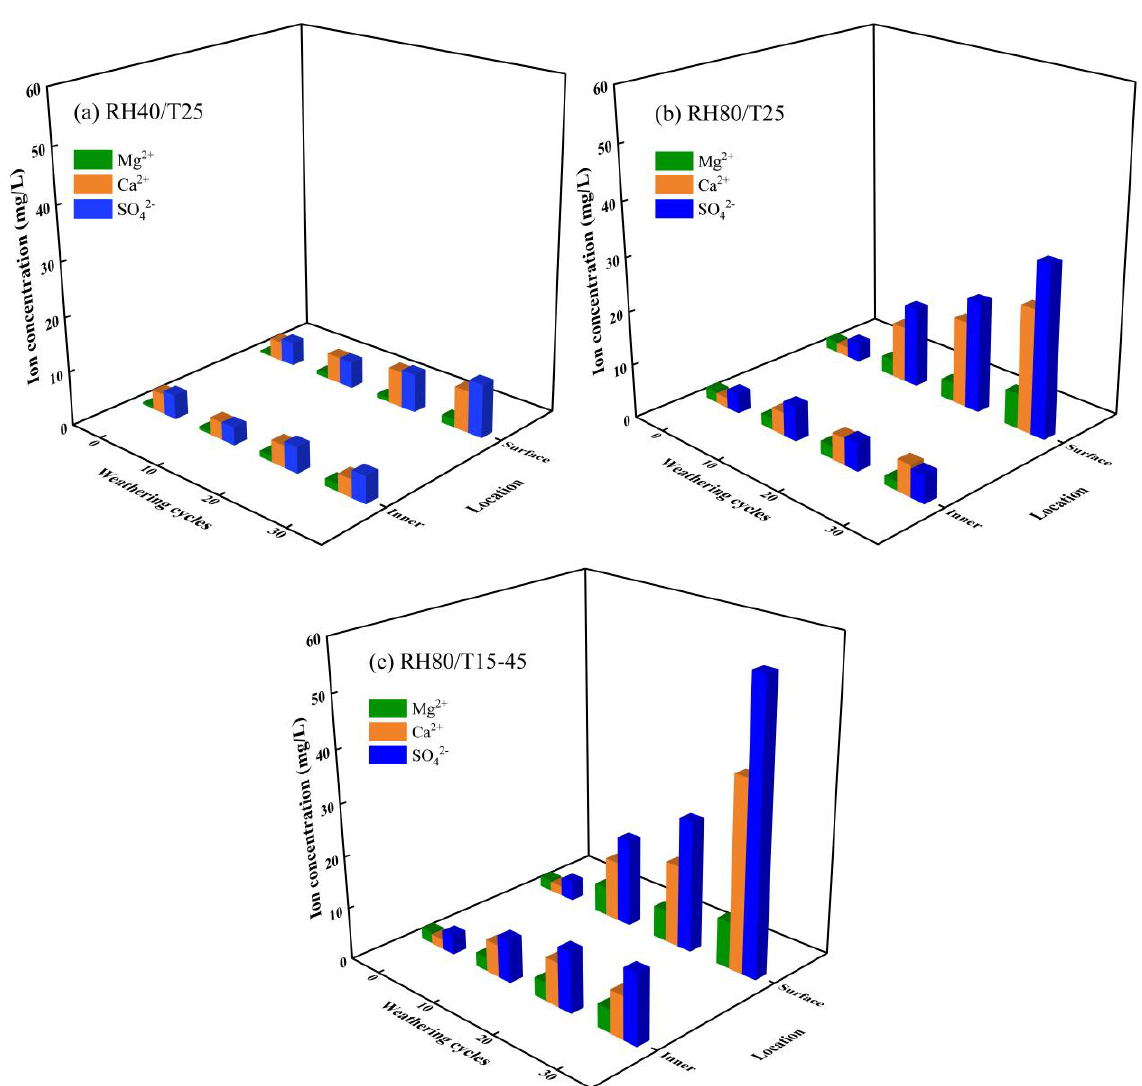
Figure 10. Variation of ion concentrations in sandstone specimens during weathering tests: ( a ) RH=40%, T=25 ℃; ( b ) RH=80%, T=25 ℃; and ( c ) RH=80%, T=15 – 45 ℃ .